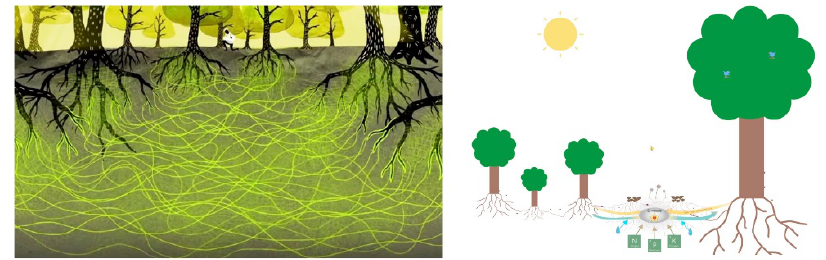
Figure 1. MN shows how communication and resource exchange between plants and fungi takes place, and Reciprocal resource exchange between plants through MN, carbon (CO 2 ) transferred by trees in exchange for water (H 2 O), nitrogen (N), phosphorus (P), sulfur (S), and other nutrients provided by the Mycorrhiza Network (MN).